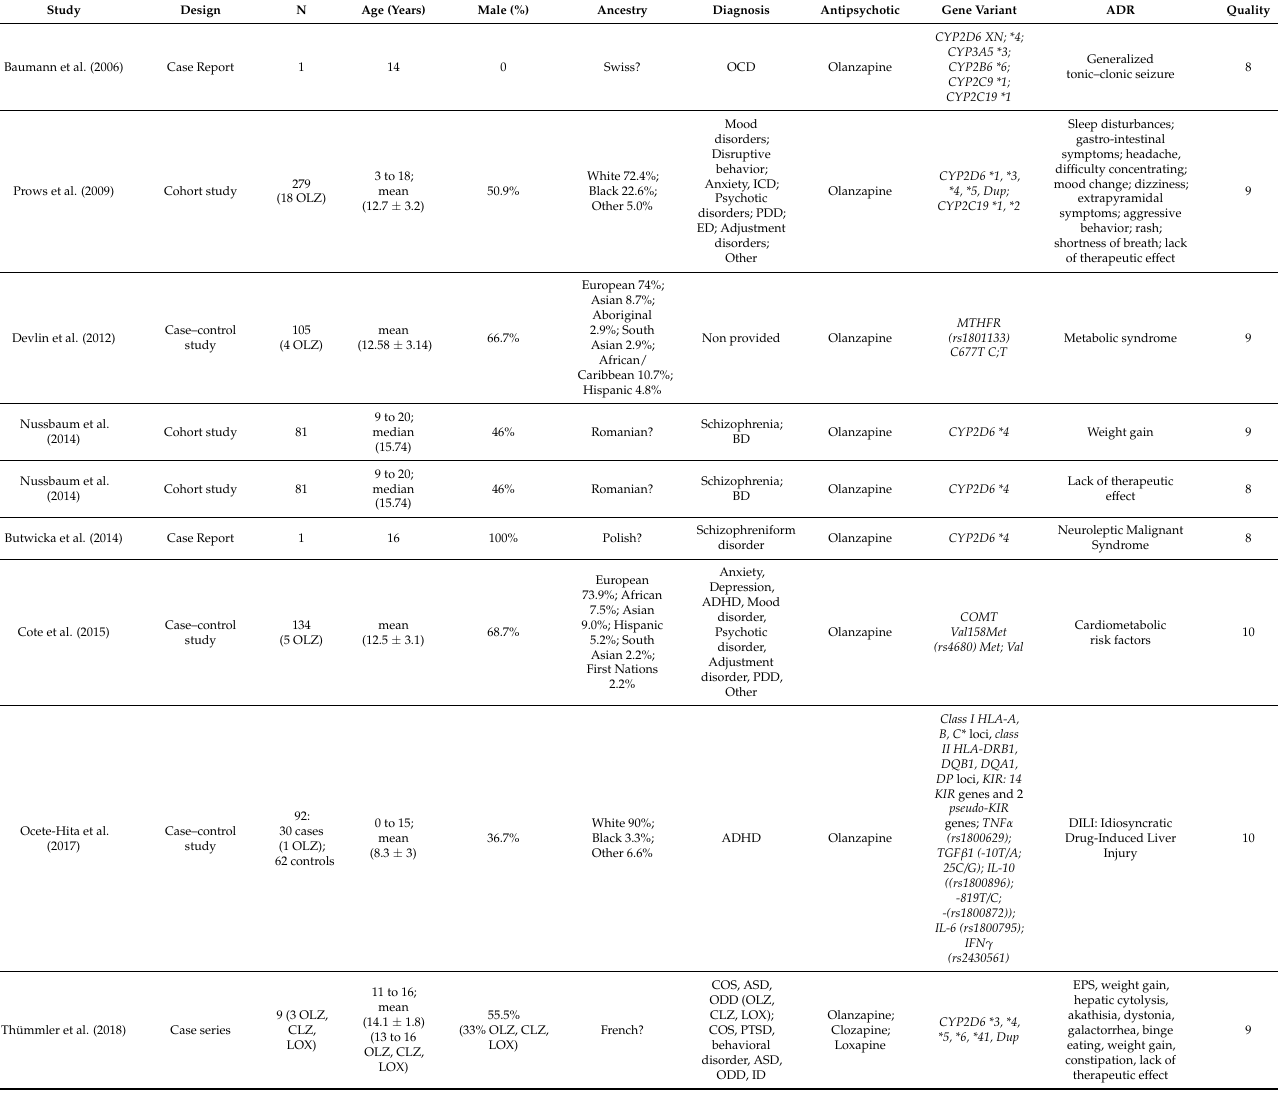
Table 1. Characteristics of the studies (pediatric